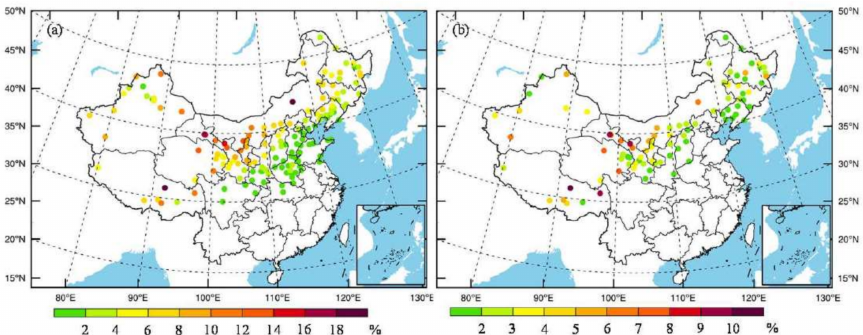
Figure 2. Contribution of dust events to the concentration of PM 10 ( a ) and PM 2.5 ( b